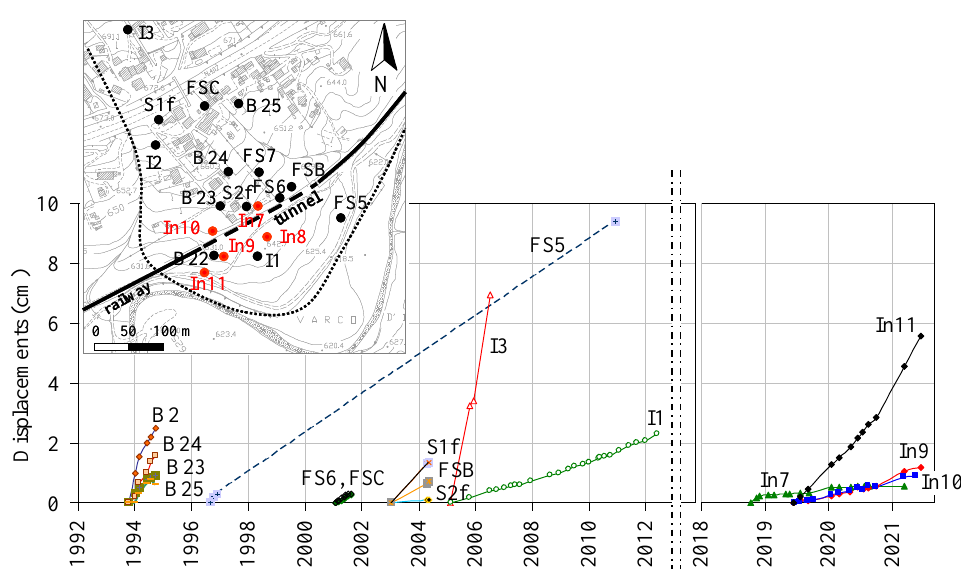
Figure 3. Deep displacements against time obtained from inclinometer data of Varco d’Izzo earthflow. Letters B, S, FS, I indicate inclinometers installed in different monitoring campaigns since 1992.